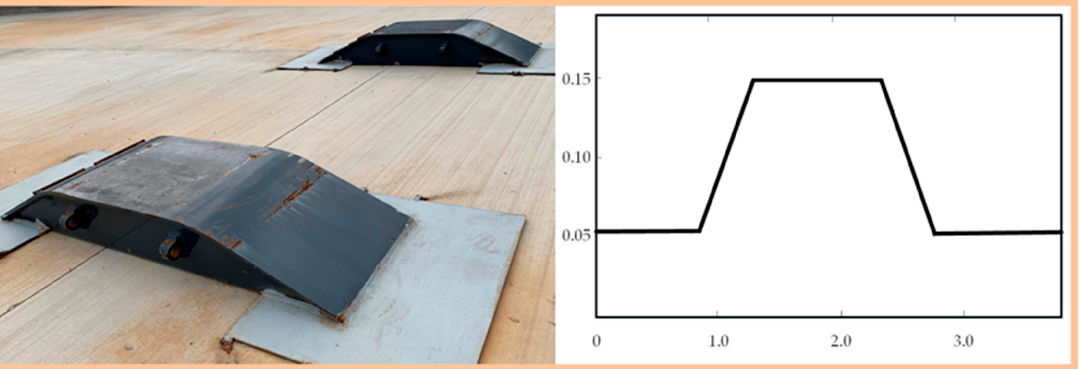
Figure 7. Obstacle at test site.